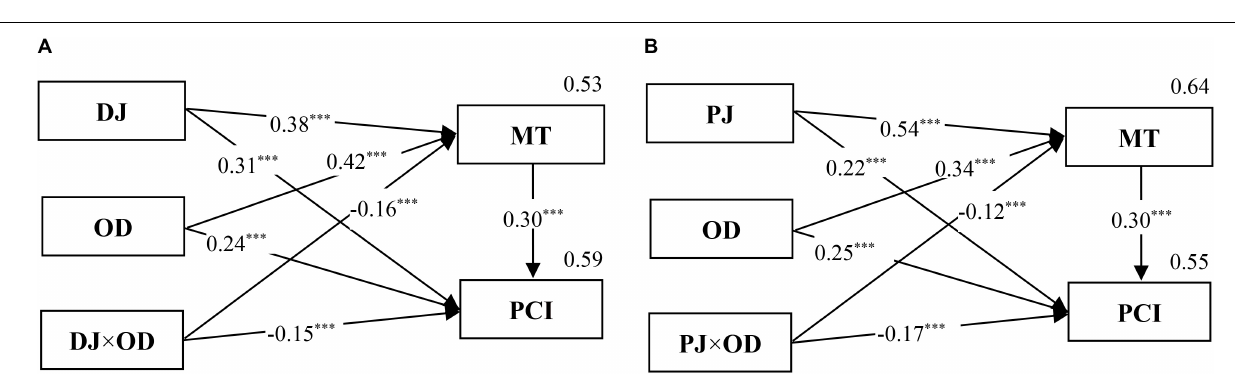
FIGURE 8 | The mediated moderation model of DJ (A) , PJ (B) , OD, and MT on PCI (Study 2). n = 1,240; ∗∗∗ p <